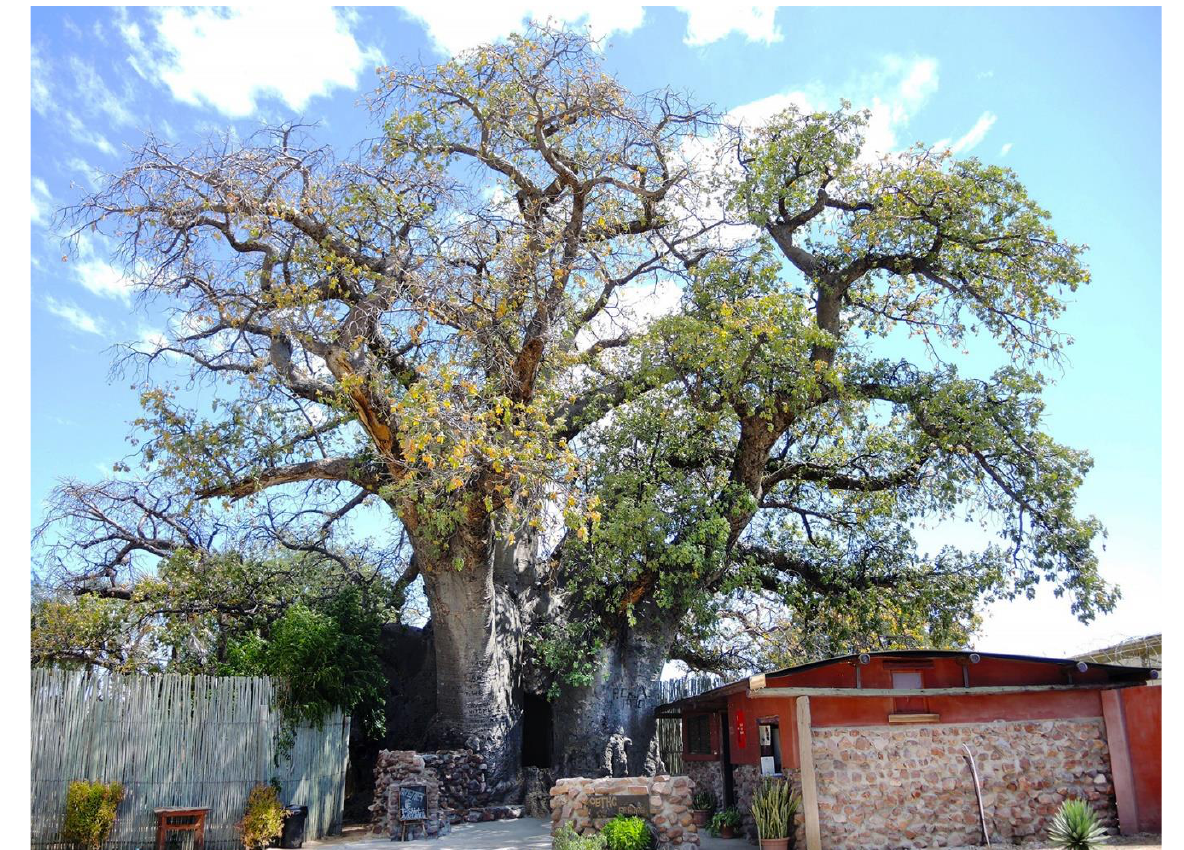
Figure 2. The Ombalantu baobab inside the Ombalantu Baobab Tree Heritage Site (opened in 2013). The door to the cavity has a height of 1.76 m.